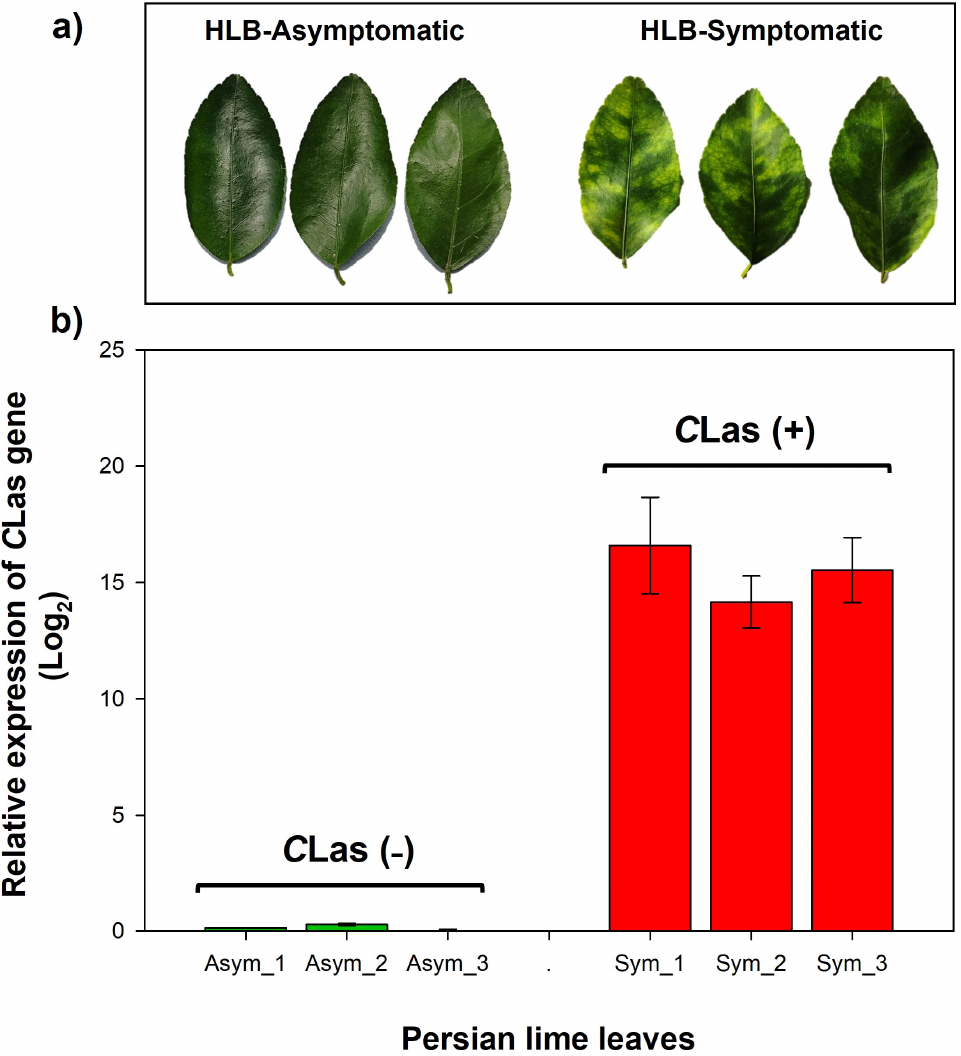
Figure 1. ( a ) HLB contrasting symptoms in Persian lime ( Citrus latifolia ) trees belonging to the Ixtacuaco Field Experiment (INIFAP) plot in Veracruz, Mexico. ( b ) RT-qPCR analysis of CLas detection in HLB-asymptomatic (Asym_1 to Asym_3) and HLB-symptomatic (Sym_1 to Sym_3) Persian lime ( C. latifolia ) leaves. Vertical bars represent means ± SD ( n = 3 per group).